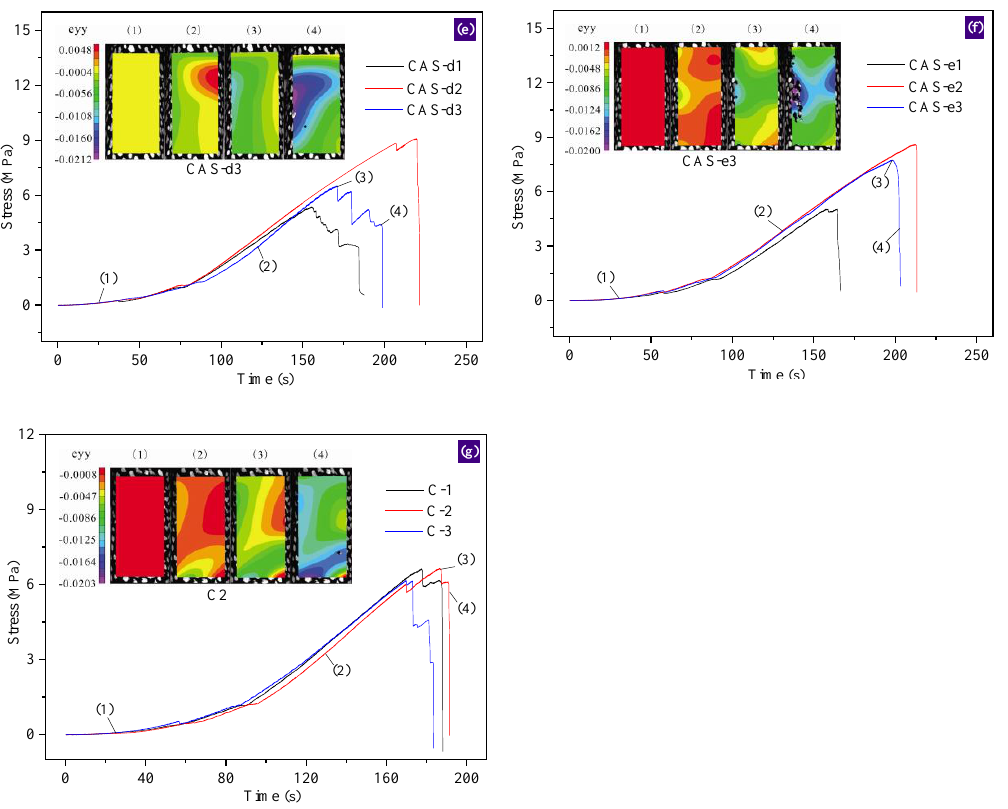
Figure 7. Stress-strain characteristics of progressive failure for combination: ( a ) coal–rock height ratio of 0:1; ( b ) coal–rock height ratio of 1:7; ( c ) coal–rock height ratio of 1:3; ( d ) coal–rock height ratio of 1:1; ( e ) coal–rock height ratio of 3:1; ( f ) coal–rock height ratio of 7:1; ( g ) coal–rock height ratio of 1:0.